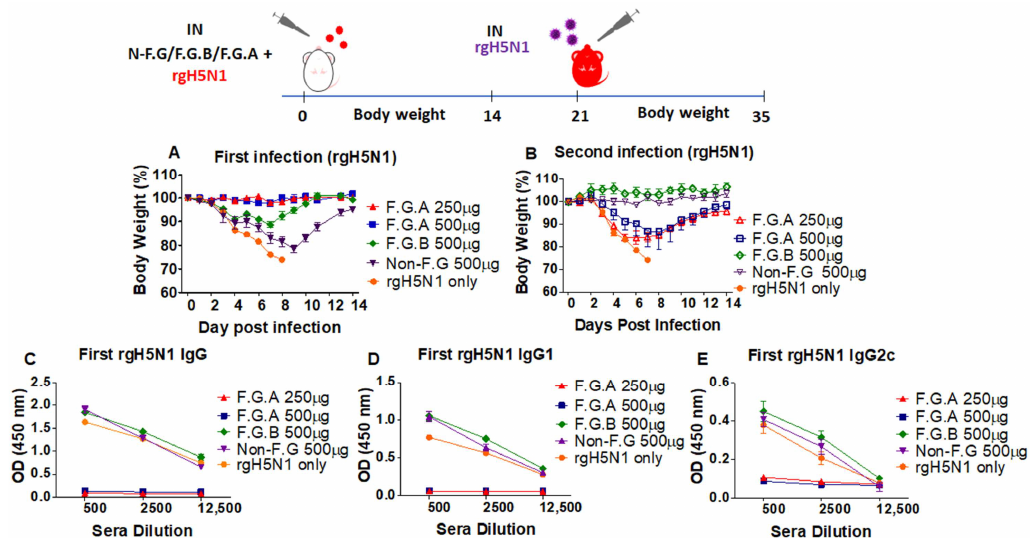
Figure 1. Fermented ginseng sample A showed higher antiviral protective activity against influenza viruses. Groups of mice ( n = 5, wild-type BALB/c mice) were intranasally (IN) infected with a mixture of 1.5 LD 50 A/Vietnam/1203/2004 (rgH5N1) and fermented ginseng sample A or B at different doses (250 µ g and 500 µ g). After 14 days of body weight monitoring, the serum sample was collected to detect the levels of IgG and IgG isotypes using a ELISA method. The mice that survived from the first rgH5N1 infection were challenged again with a lethal dose of rgH5N1 (3 LD 50 ). ( A ) Body weight change after the first infection (rgH5N1) and ( B ) body weight change after the second infection (rgH5N1). ( C ) rgH5N1-specific IgG, ( D ) IgG1, and ( E ) IgG2a after the first infection. F.G.A: rgH5N1 virus + fermented ginseng sample A; F.G.B: rgH5N1 virus + fermented ginseng sample B; non-F.G: not fermented ginseng; rgH5N1 only: virus infection without ginseng samples.